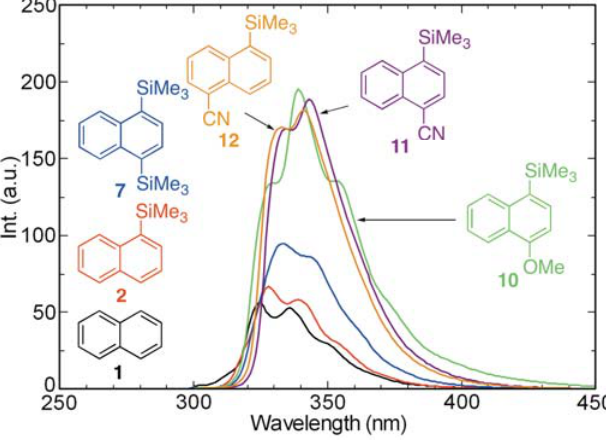
Figure 7. Fluorescence spectra of 1 , 2 , 7 , and 10–12 in cyclohexane (aerated, ca. 10 − 4 M).